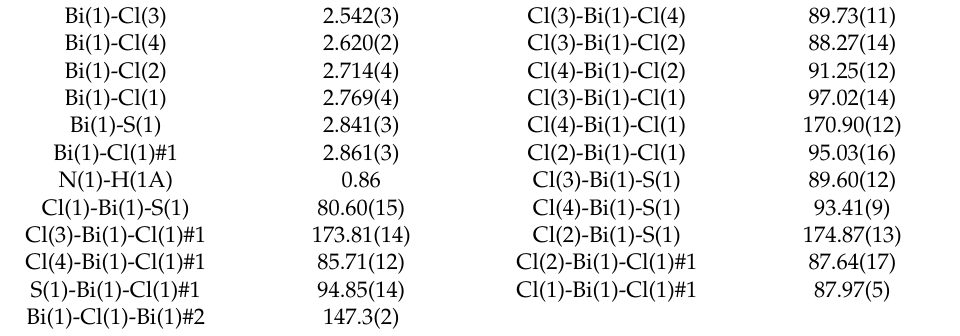
Table 2. Selected lengths and angles of bond for [Bi(HQ)(Cl) 4 ] n